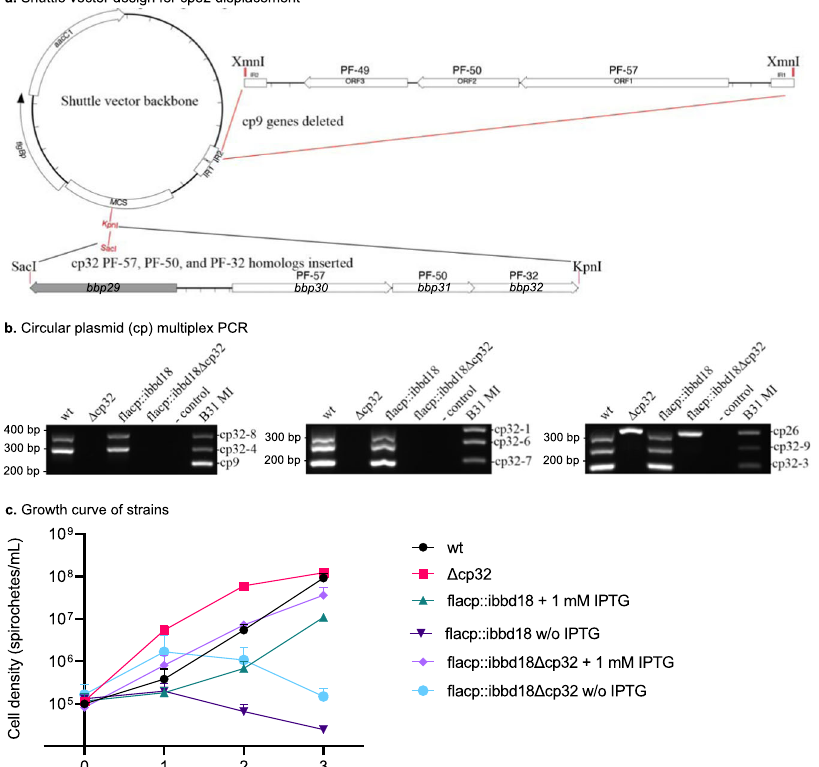
Fig.7|Thecp32plasmidsarenotsolelyresponsibleforcelllysisintheabsence ofBBD18.a Shuttlevectordesigntodisplacecp32plasmidswithincompatible,but unstable plasmids. PF-57, PF-50, and PF-32 support shuttle vector replication and are incompatible with their cognate plasmids, but are inherently unstable because the PFam49/ parB gene is not included. b Multiplex PCR of circular plasmids in isogenic B31 wt (A3-68-LS), △ cp32, fl acp::ibbd18, and fl acp::ibbd18 Δ cp32 strains. B31 MI is a positive control containing all plasmids. The agarose gel presented is a